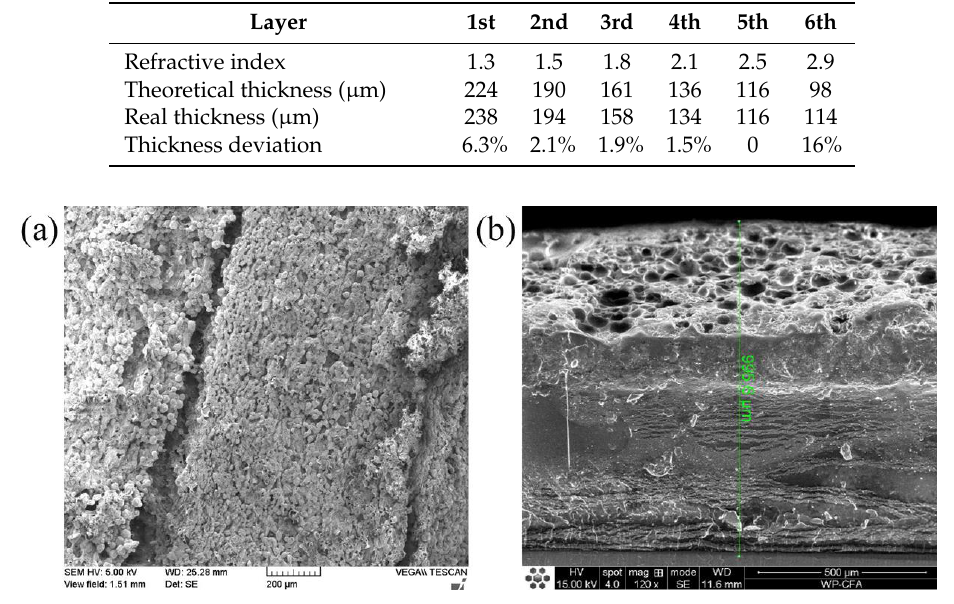
Figure 6. SEM images of the flat six-layer AR structure: ( a ) top view; ( b ) cross section.